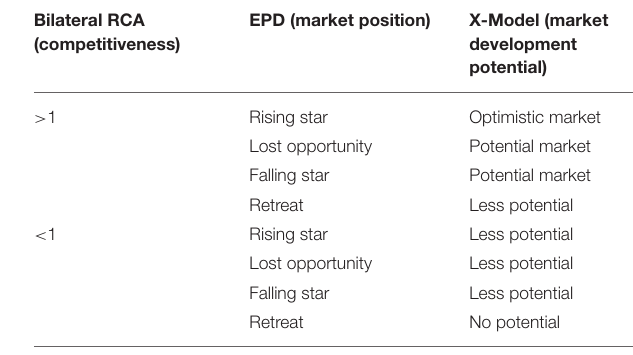
TABLE 1 | Clustering X-model potential export